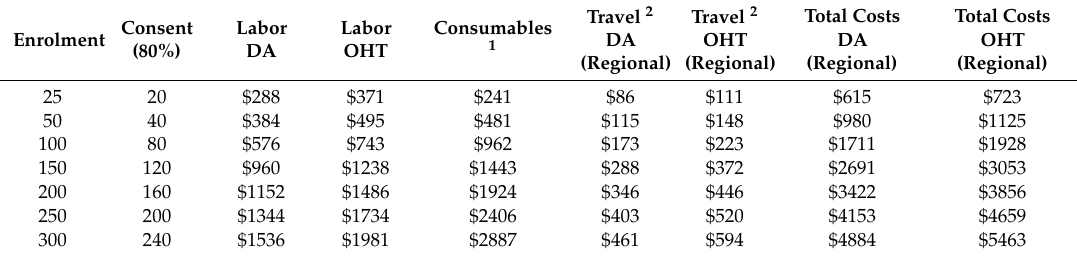
Table 4. Cost models for a support a school-based fluoride varnish program based on di ff erent enrolment levels and provider type.